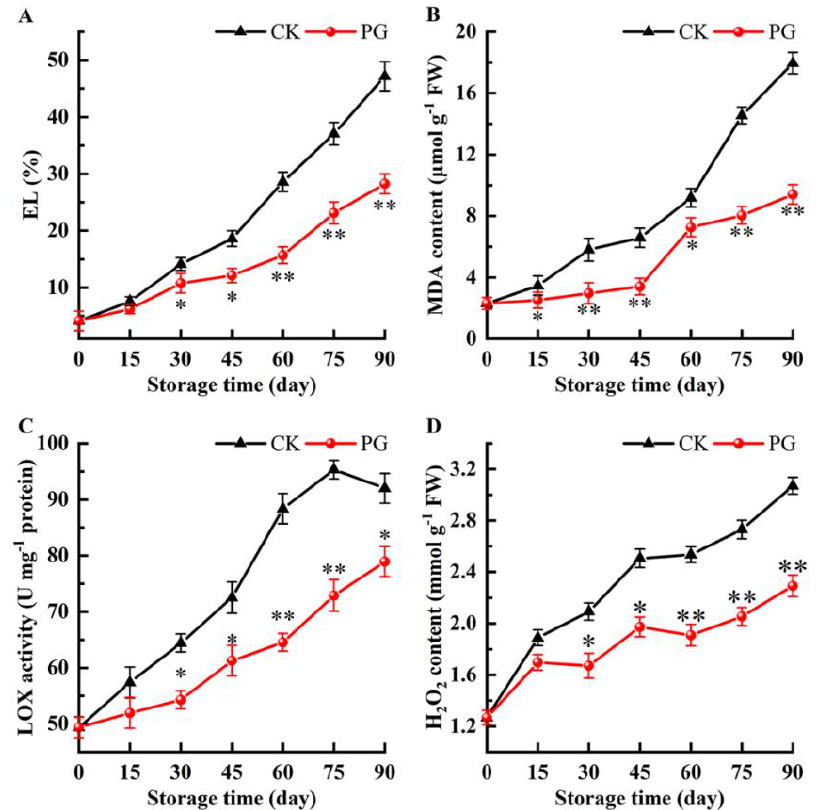
Figure 5. Effects of PG treatment on electrolyte leakage (EL) ( A ), malondialdehyde (MDA) content ( B ), lipoxygenase (LOX) activity ( C ), and hydrogen peroxide (H 2 O 2 ) content ( D ) in the peel. Vertical bars represent the SE of the mean. The asterisks indicated significant difference between two treatments during the same storage period (* p < 0.05, ** p < 0.01).